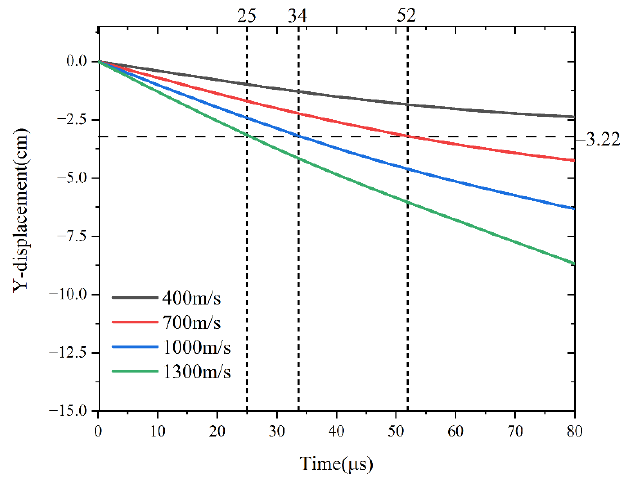
Figure 24. The time-history curve of Y-direction displacement of the projectile center of mass under different initial velocities.